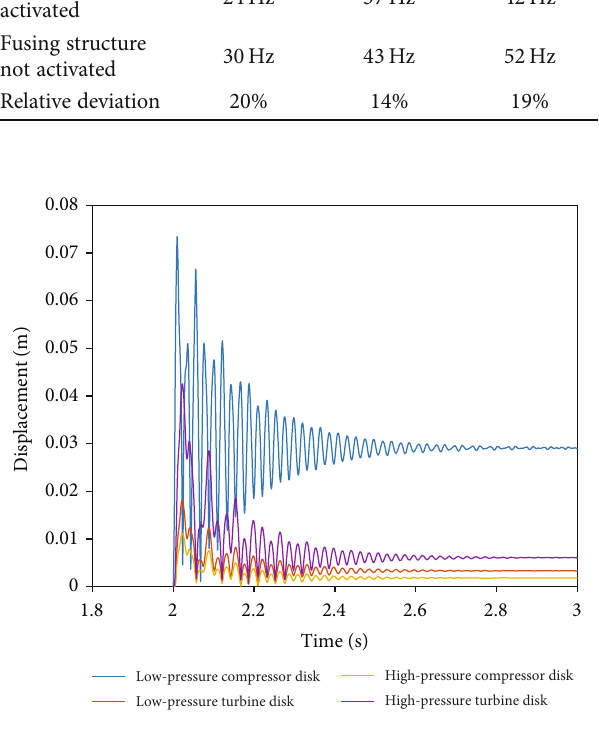
Figure 13: Displacement response of a dual-rotor system with varied-sti ff ness fusing structure.